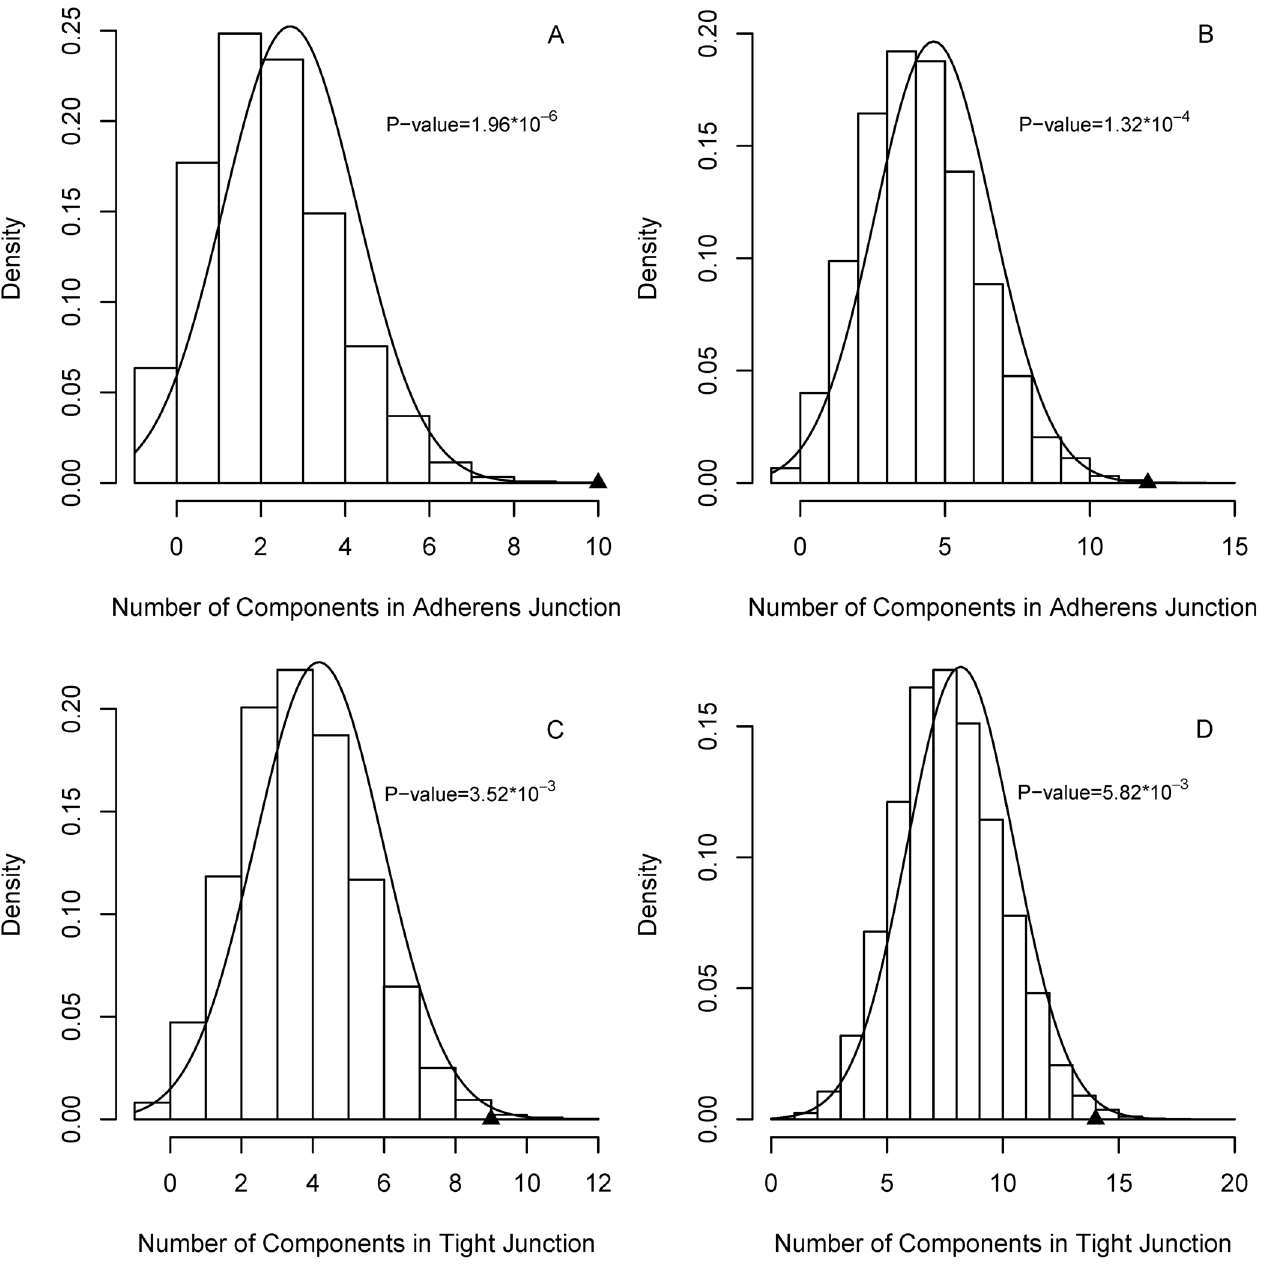
Fig 5. Probability density for obtaining the number of components in adherens and tight junction pathways. (A) and (C) for PD, (B) and (D) for AD; the observed value is marked with a filled